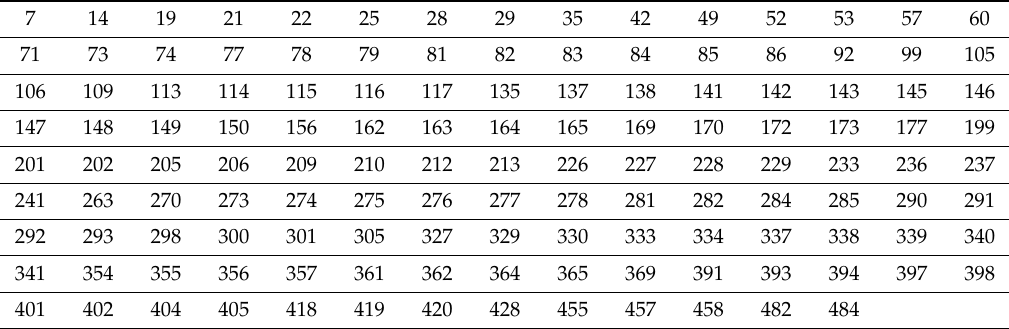
Table 14. x3 and x5 corresponding to block P texture template (decimal).